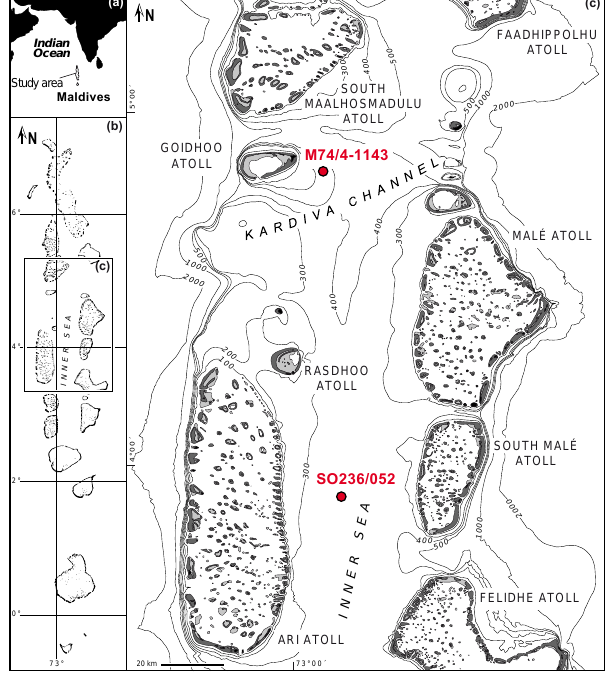
Figure 1. Location maps of the Maldives archipelago in the Indian Ocean (a, b) and the setting of the study area (c) (modified after Betzler et al., 2013a), showing the location of sediment core M74/4- 1143 in the Kardiva Channel and core SO236-052-4 in the central part of the Inner Sea (red